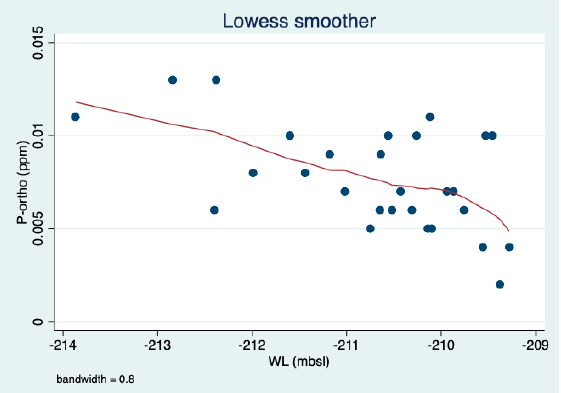
Figure 9. Trend of changes (Lowess Smoother, 0.8 bandwidth) of annual lake averages of orthophos- phate concentration (ppm scale range: 0.000–0.015) vs. WL (mbsl) during 1969–2001.